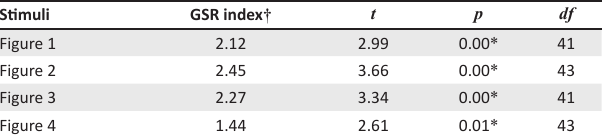
TABLE 1: Galvanic skin response baseline results: Text and picture. Stimuli